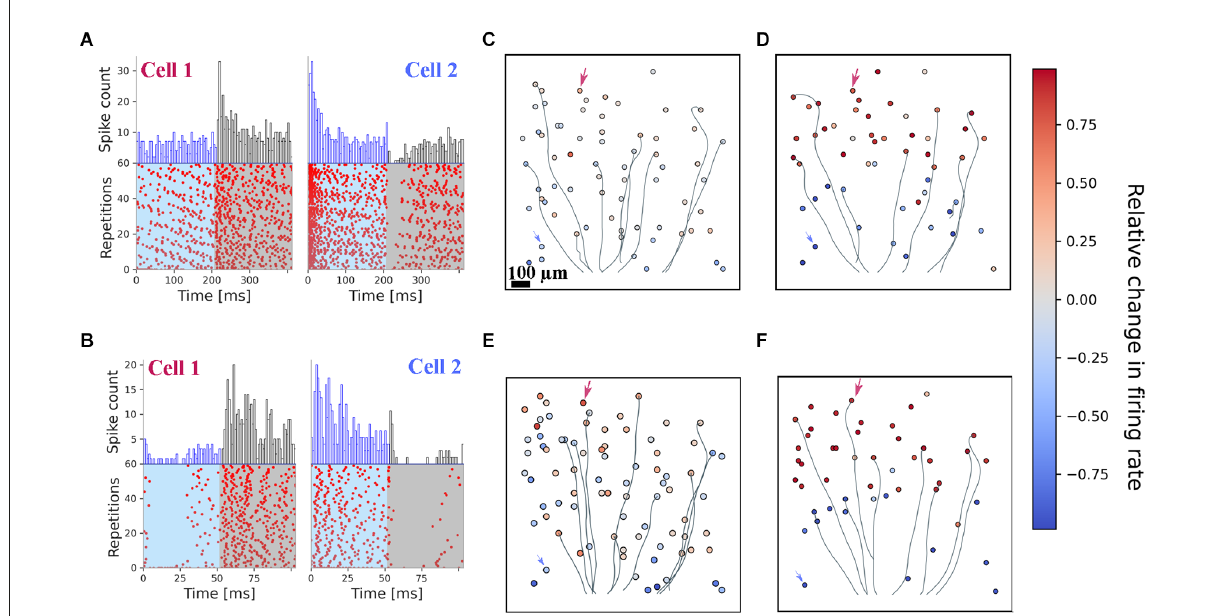
FIGURE2 Optogenetic stimulation with fine gratings evokes spatially restricted RGC spiking. All results presented here originate from one retina. (A) Raster plots of two exemplary RGCs stimulated for 24 s with an alternating stimulus at a spatial frequency of 50 µ m. Every 200 ms, the spatial pattern was switched. A preferential activation is detected for both cells. (B) Raster plots of the very same RGCs, for a stimulus presented at 10 Hz temporal switching and a 50 µ m grating width. Both RGCs cells show a preferential response to one of the two stimulation phases. (C,D) Spatial mapping of identified RGCs for the 2.5 Hz pattern switching with a 50 µ m (C) and 500 µ m (D) grating width. Color coded is the relative change in firing rate between the two stimulation phases. Arrows indicate the two selected cells’ positions depicted in panel (A) . RGC axons are inferred from the spike-triggered averaging; only a few of them are shown here for visualization purposes. (E,F) Spatial mapping of identified RGCs for the 10 Hz pattern reversal with a spatial frequency of 50 µ m (E) and 500 µ m (F) . Color coded is the relative change in firing rate between the two stimulation phases. Arrows indicate the two selected cells’ positions depicted in panel (B)